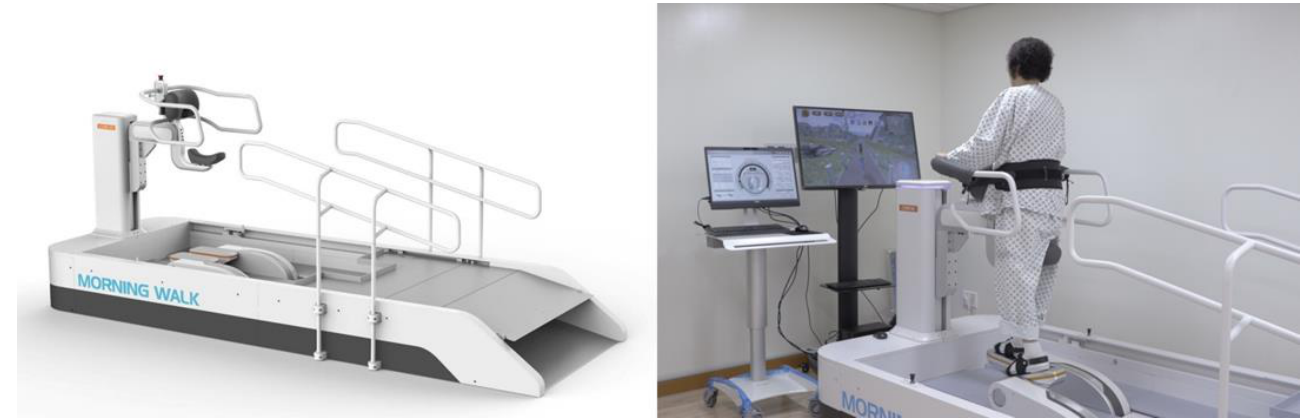
Figure 1. The Morning Walk ® (Curexo, Seoul, South Korea) which is an end-effector type robot. It uses a saddle for body-weight support.